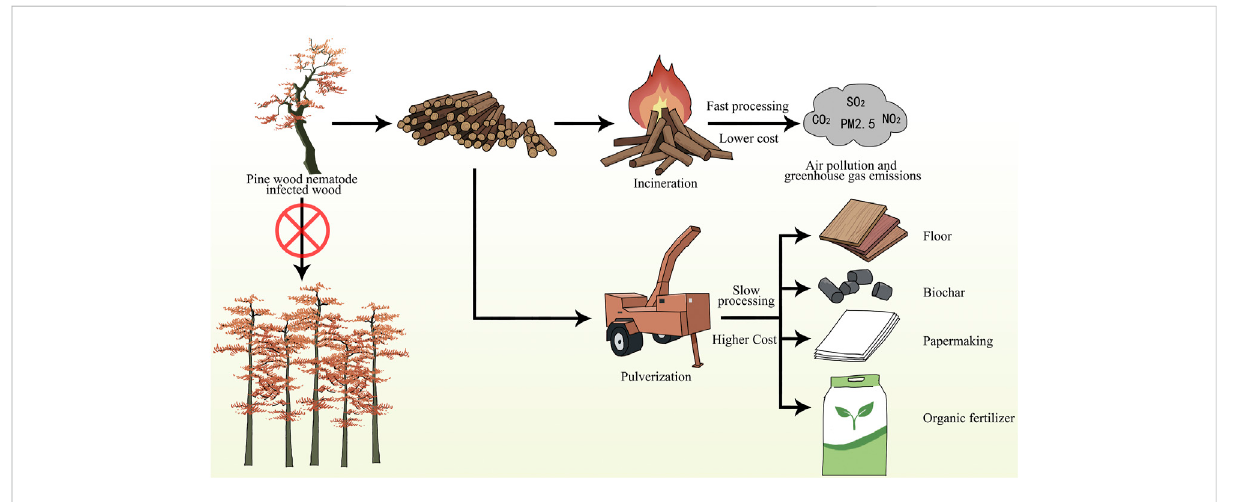
FIGURE 1 Main issues in nematode-infected pine wood